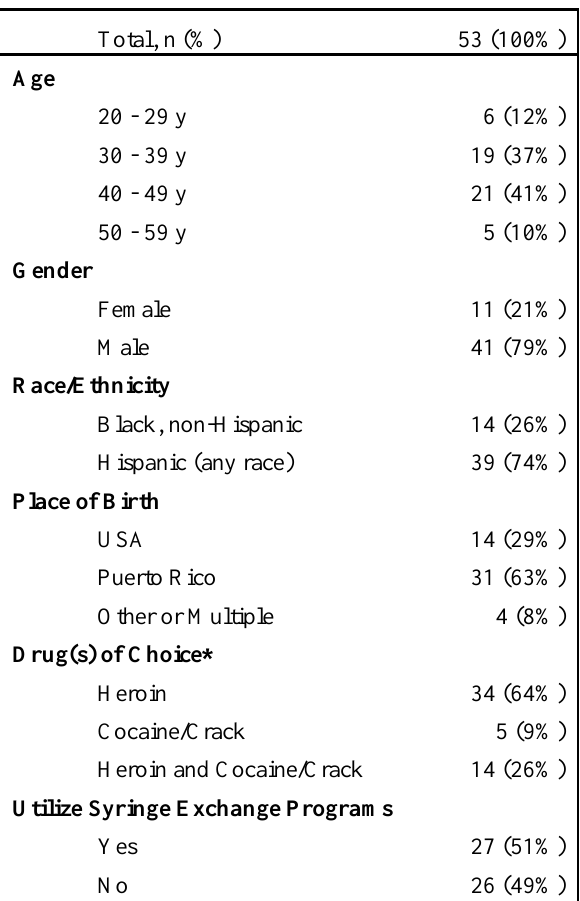
Table 1. Participant